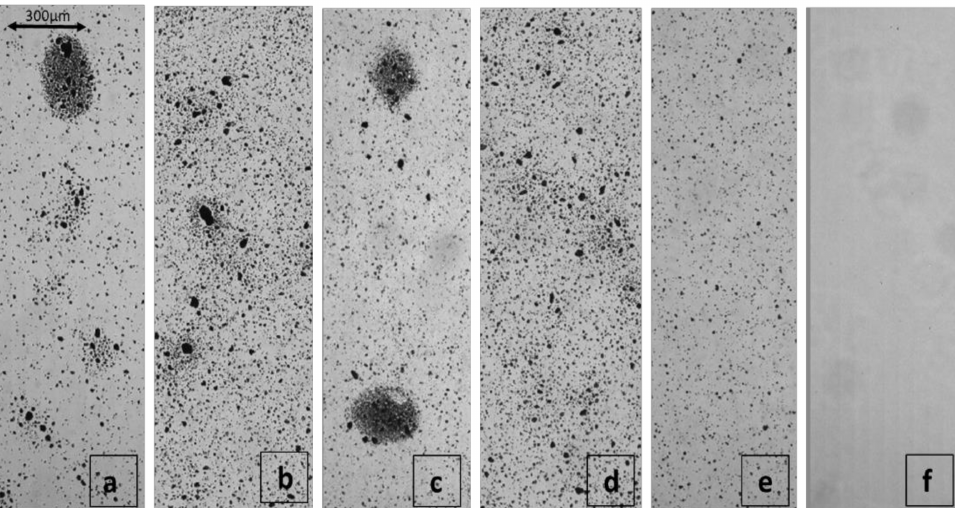
Figure 2. Microscopy images of lignin suspension in water obtained using oCelloScope after different grinding cycles of ( a ) 10, ( b ) 20, ( c ) 30, ( d ) 40, and ( e ) 100. ( f ) Represents the microscopic image of lignin nanoparticles suspension recovered as filtrate in the membrane filtration indicating no visible microscopic particles.